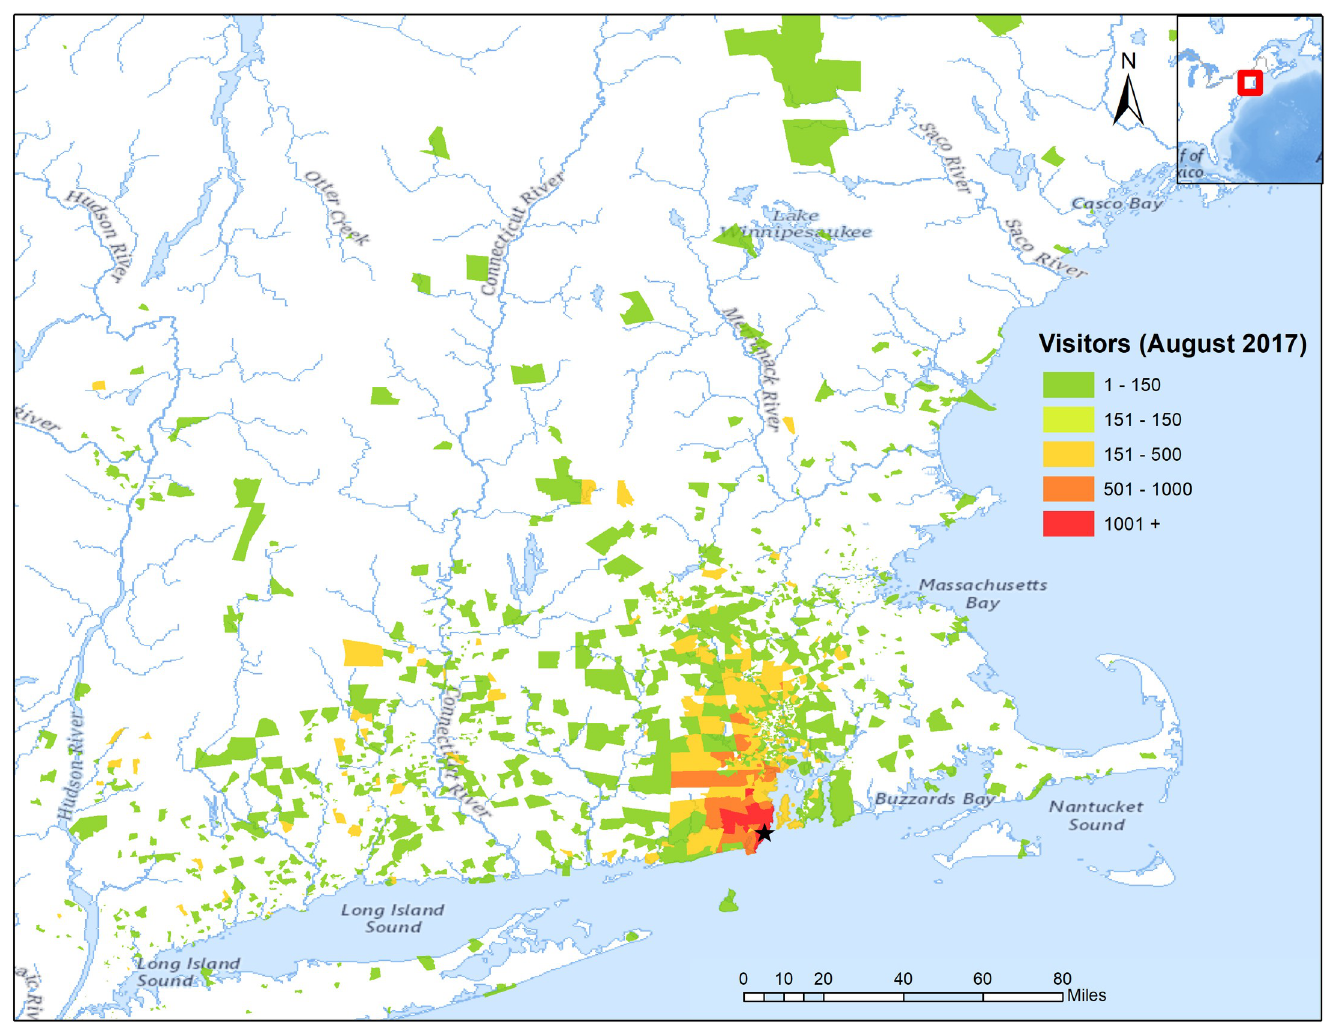
Fig 6. Visitor origins for Narragansett Beach, RI, USA. Count of visitors by census block group origins for visitors to Narragansett Town Beach, Narragansett RI, USA, (black star on the map) in August 2017. This monthly origin information exists for each of the 577 access points in our sample.